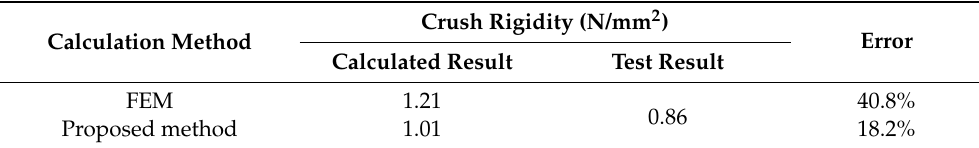
Table 4. Comparison of the proposed method with FEM and physical